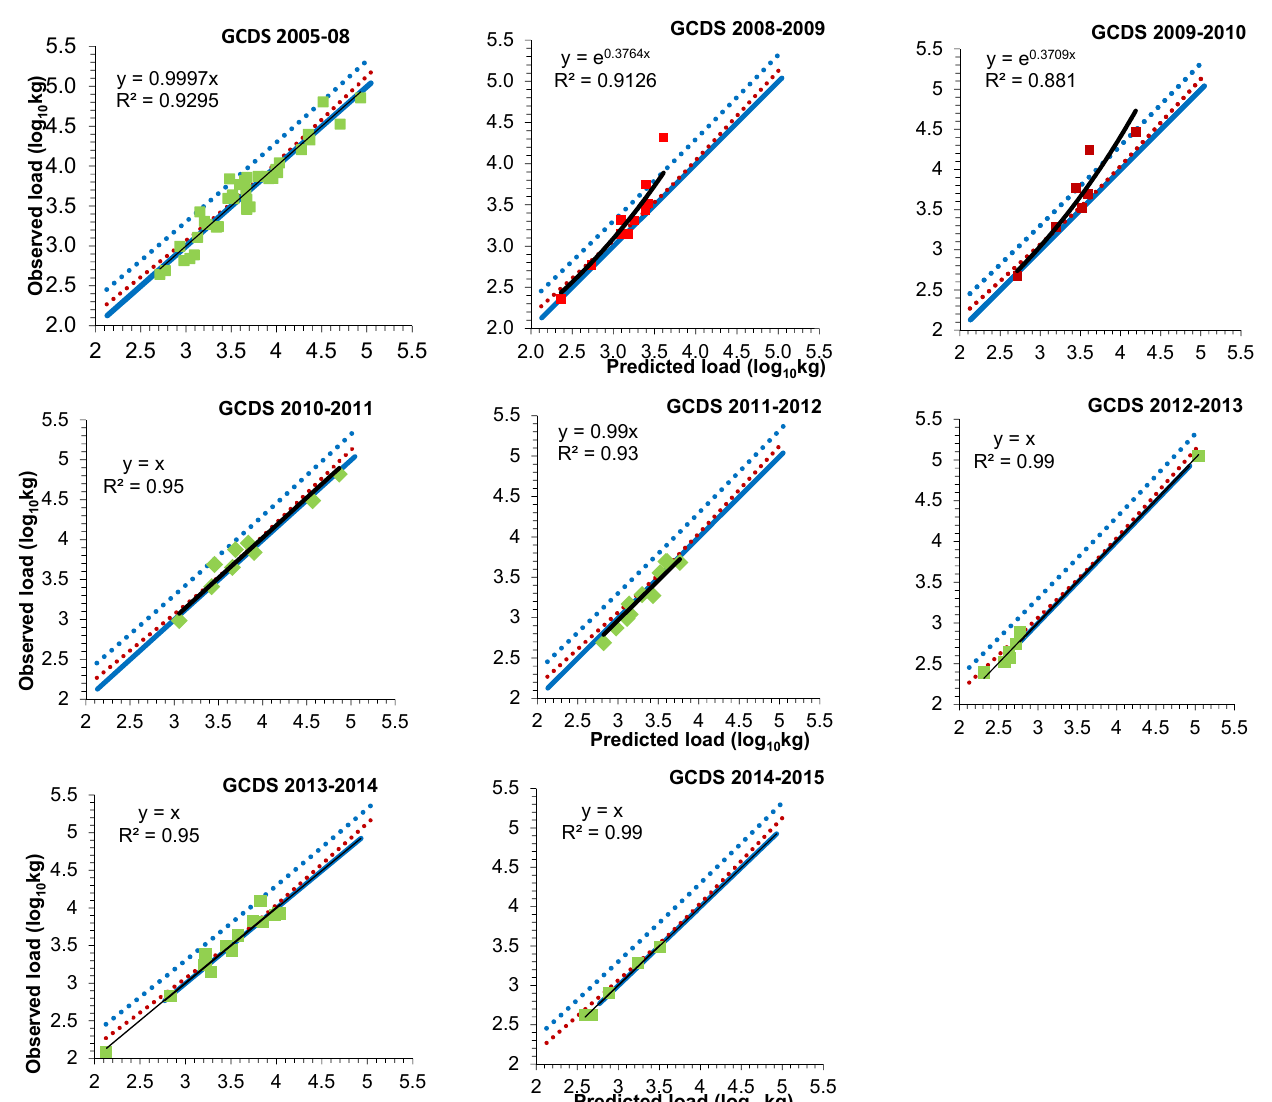
Figure A2. Relationship between OTL and PTL at GCDS (2005–2015).